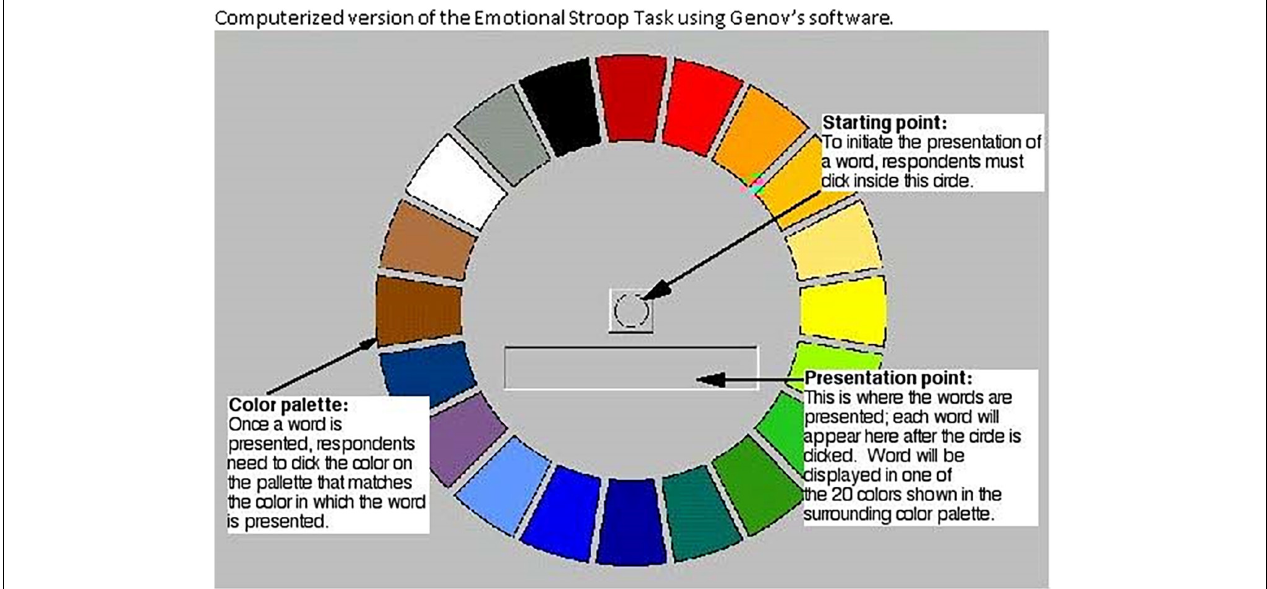
FIGURE 1 | Computerlzed version of the Emotional Stroop Task using Genov’s